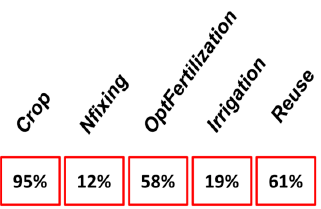
Figure 4. Example of agriculture related group of measures chromosome codification representing the level of intensity with which each measure is applied. Combined with the priority maps, will lead to select more or less pixels where applying the measures. Table 2. Overview of the three groups of abatement measures used in the preliminary optimization exercise. The groups are defined according to the type of sector or effect on which each measure has significant influence.